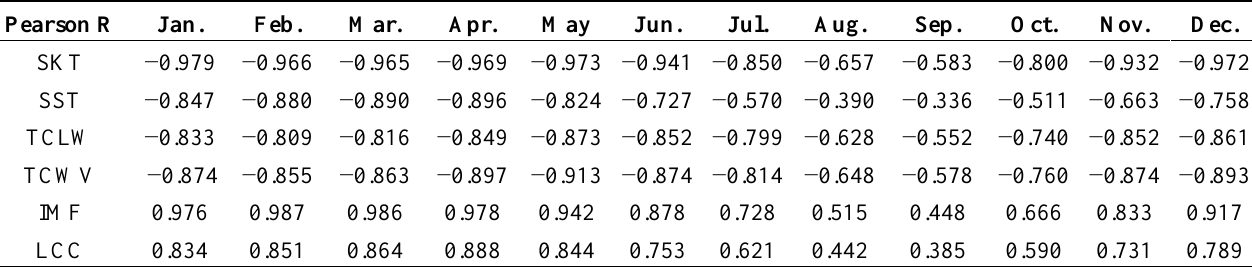
p -value < 0.01 for all cases. Table 4. Validation of monthly sea ice concentration in 2012 using the OLS regression models calibrated for each month during 1979–2011. The values for the entire pixels were aggregated.